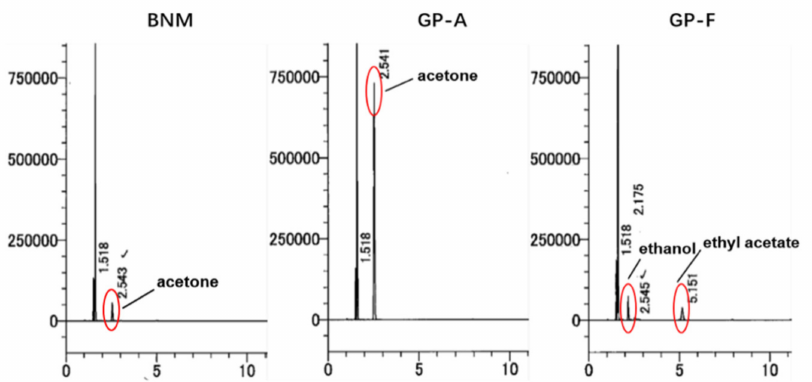
Figure 6. Chromatograms of the residual solvents in solutions of BNM ( left ) and GPs ( middle and right ). Red circles highlight peaks that indicate residual solvents (acetone, ethanol, and ethyl acetate) detected by headspace gas chromatography.